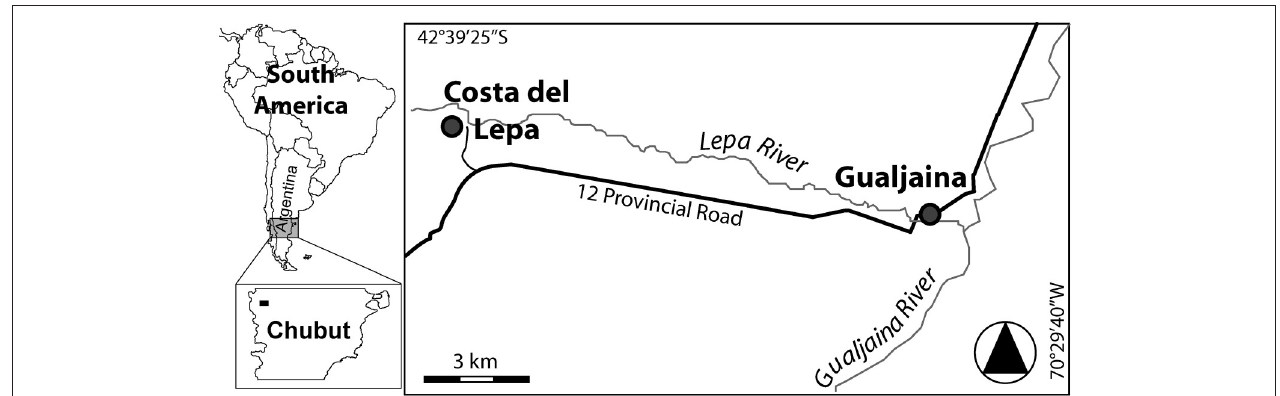
FIGURE 1 | Location of the study area in NW Chubut province, Argentina.